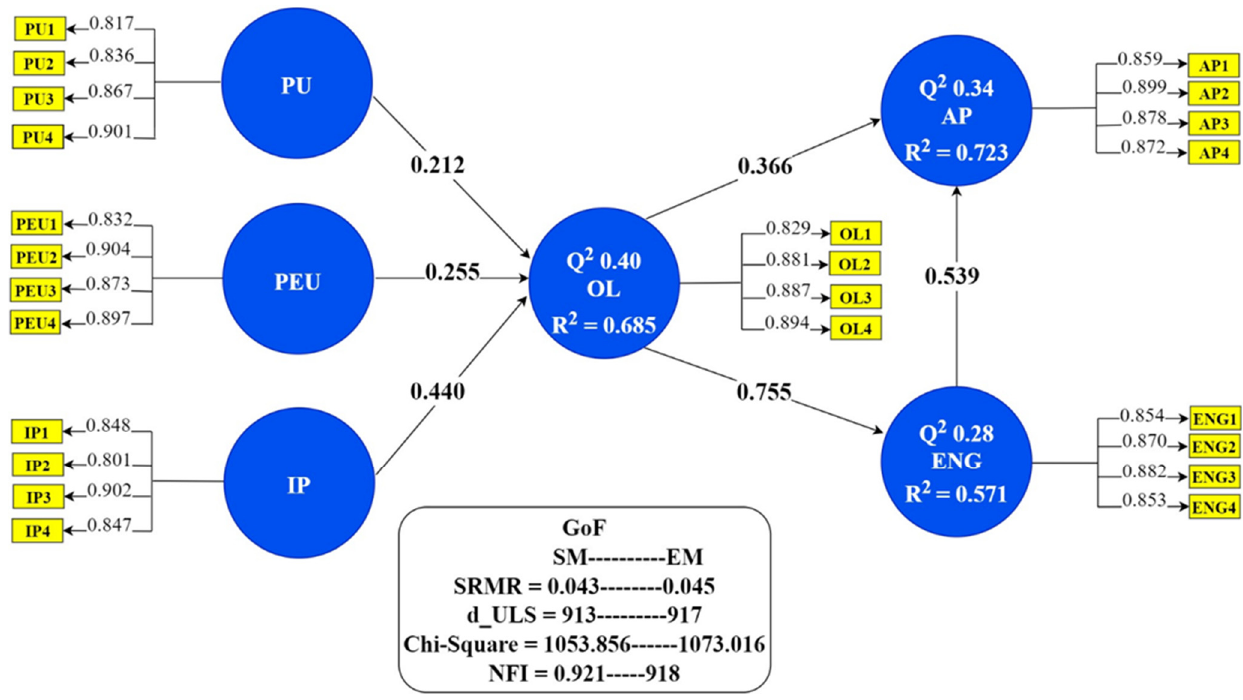
Figure 2. Results of proposed model.